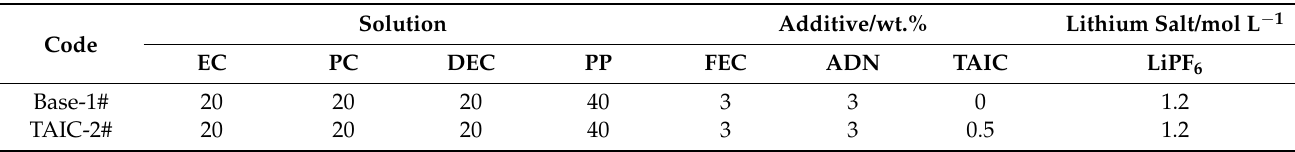
Table 1. The compositions and codes of various